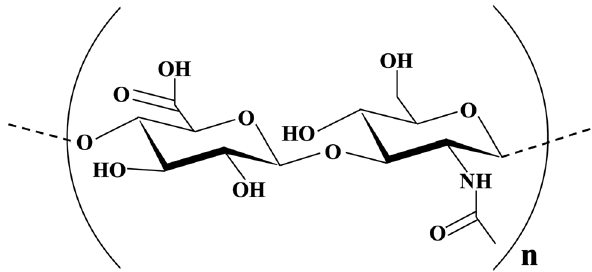
Figure 1: The chemical structure of HA. Repeating sugar molecules form the backbone of the HA